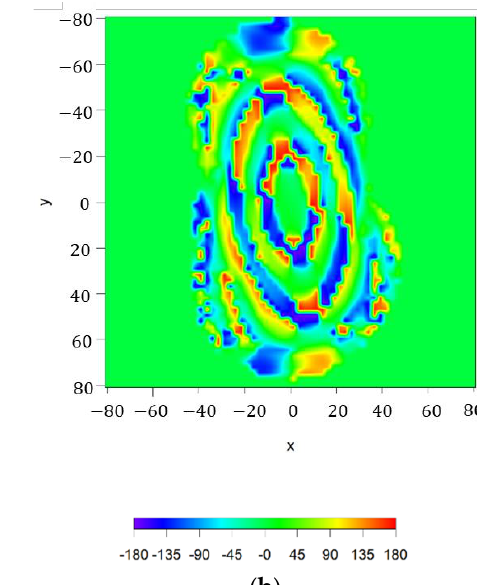
Figure 17. Layout of the antenna array with an inclusion of 5 × 5-element subarrays and by delet- ing the low-excited elements ( |𝐼| 𝑚𝑎𝑥 /|𝐼| 𝑚𝑖𝑛 ) = 46.81). Final number of array elements: 695.